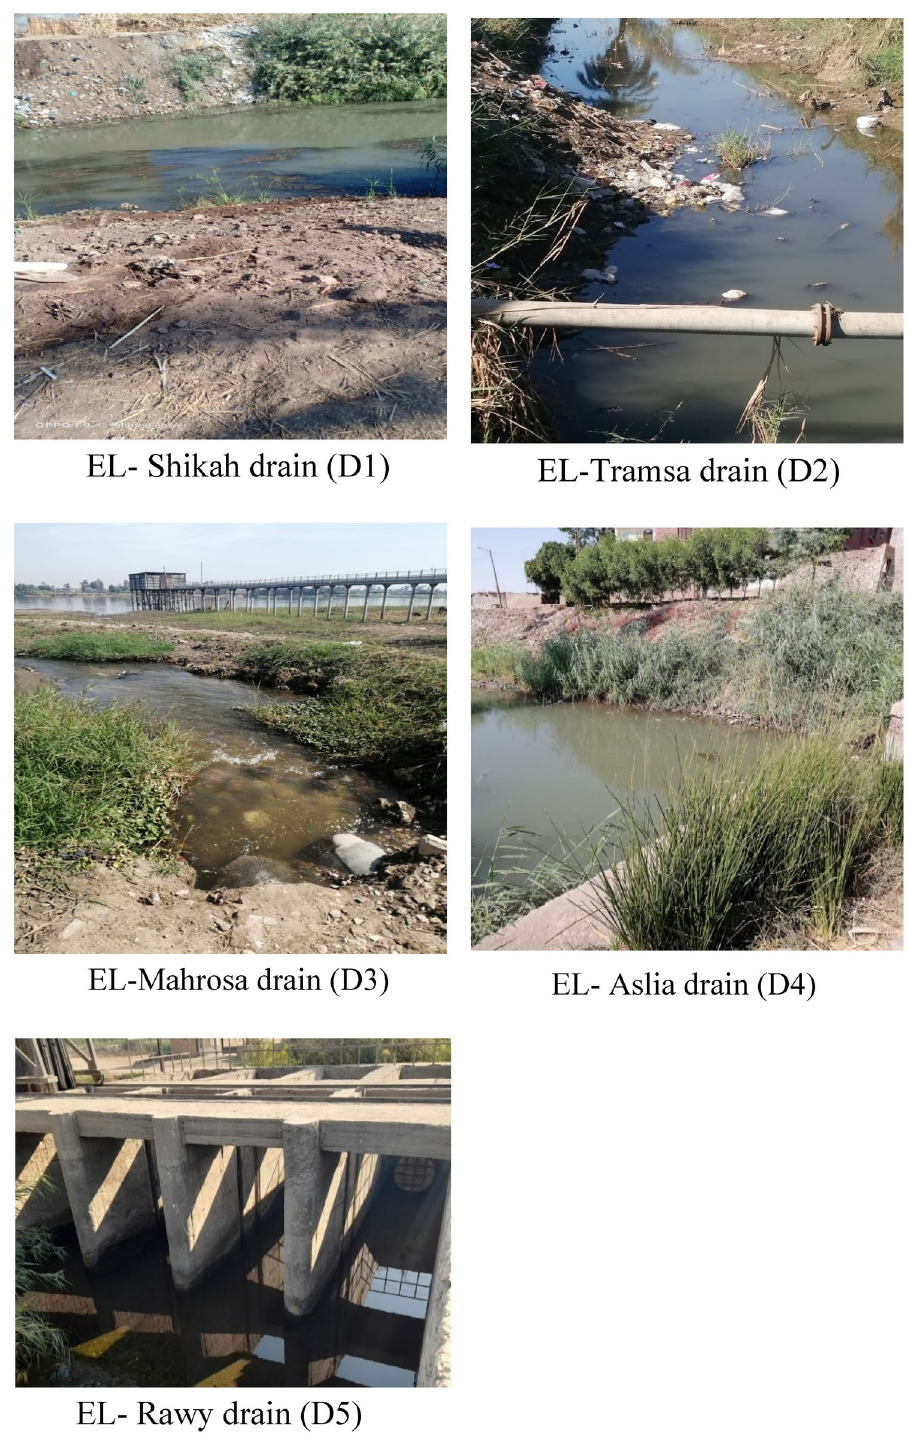
Figure 2. Irrigation drain under